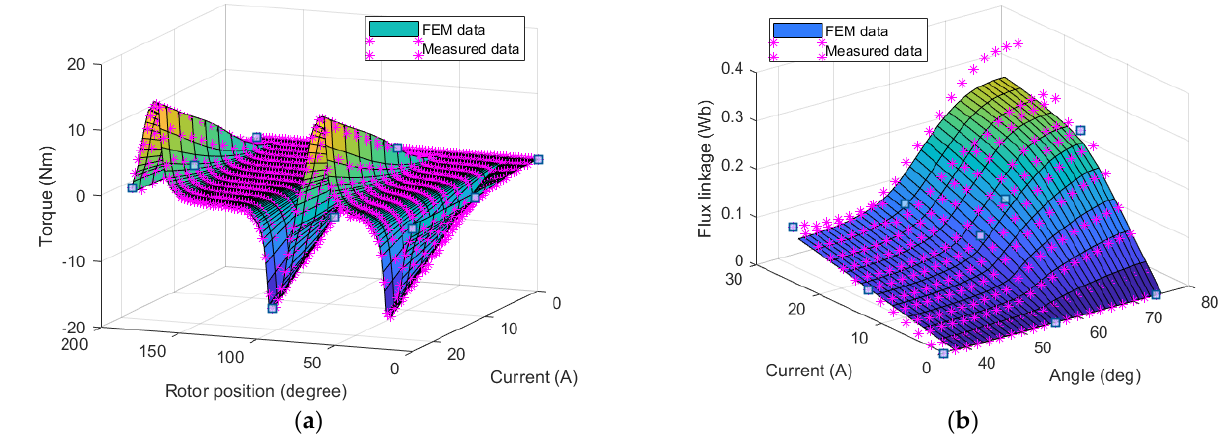
Figure 19. The FEM results and measured static data of the proposed SRM: ( a ) the torque; ( b ) the flux linkage.